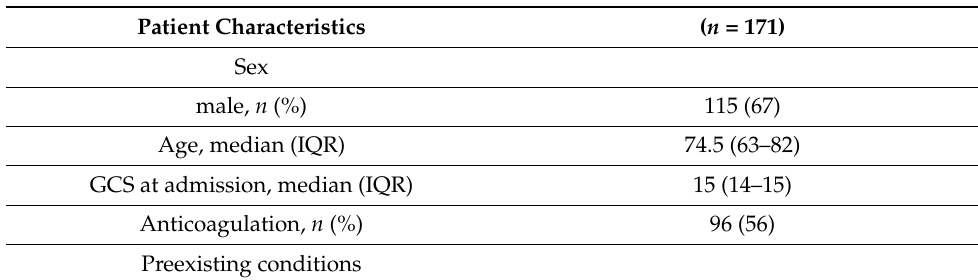
Table 1. Demographics, management, and surgical data. IQR: Inter quartile range; GCS: Glasgow Coma Score; mRS: Modified rankin